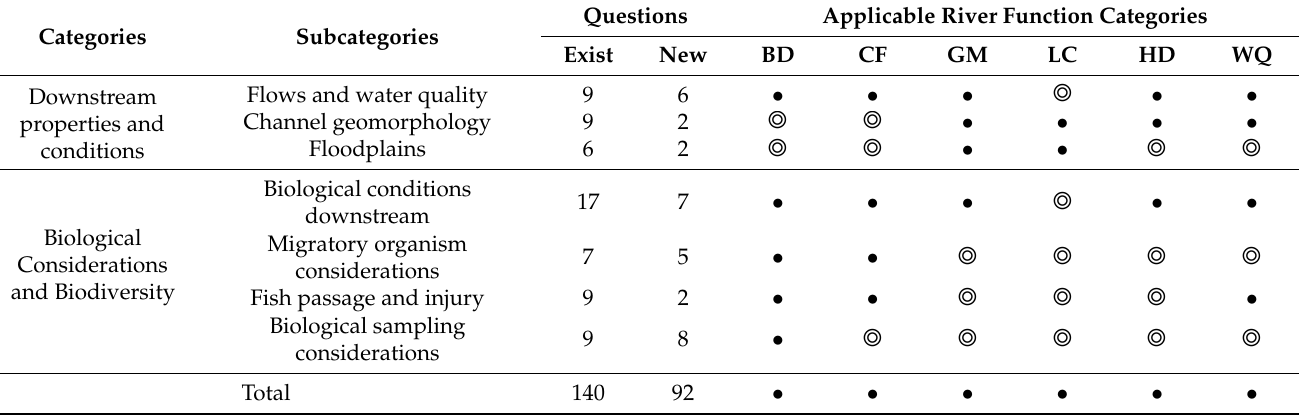
Table 2. Number of questions within each section of the spreadsheet tools (“Existing” refers to the spreadsheet program for existing dams whereas “New” refers to the program for new development) and their relationship to each river function indicator category.